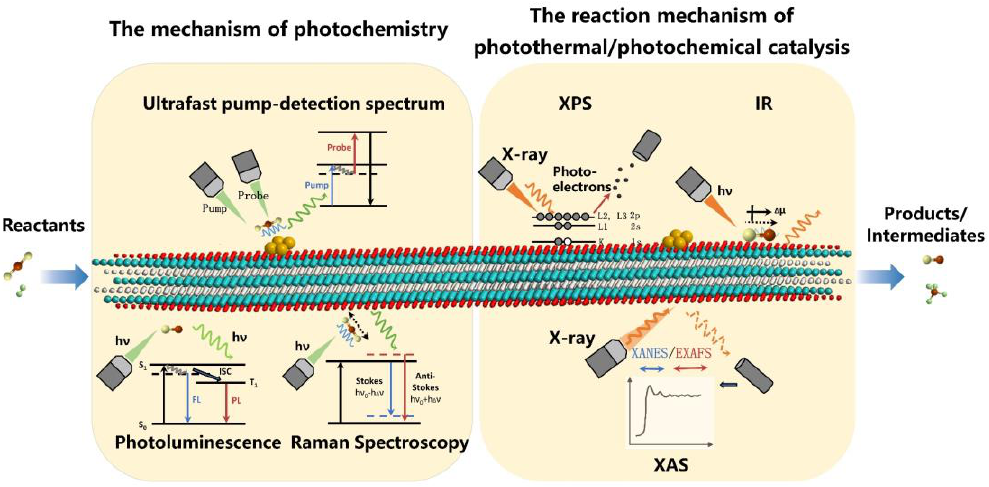
Figure 10. In situ characterization techniques of MXene-based photothermal catalysts.